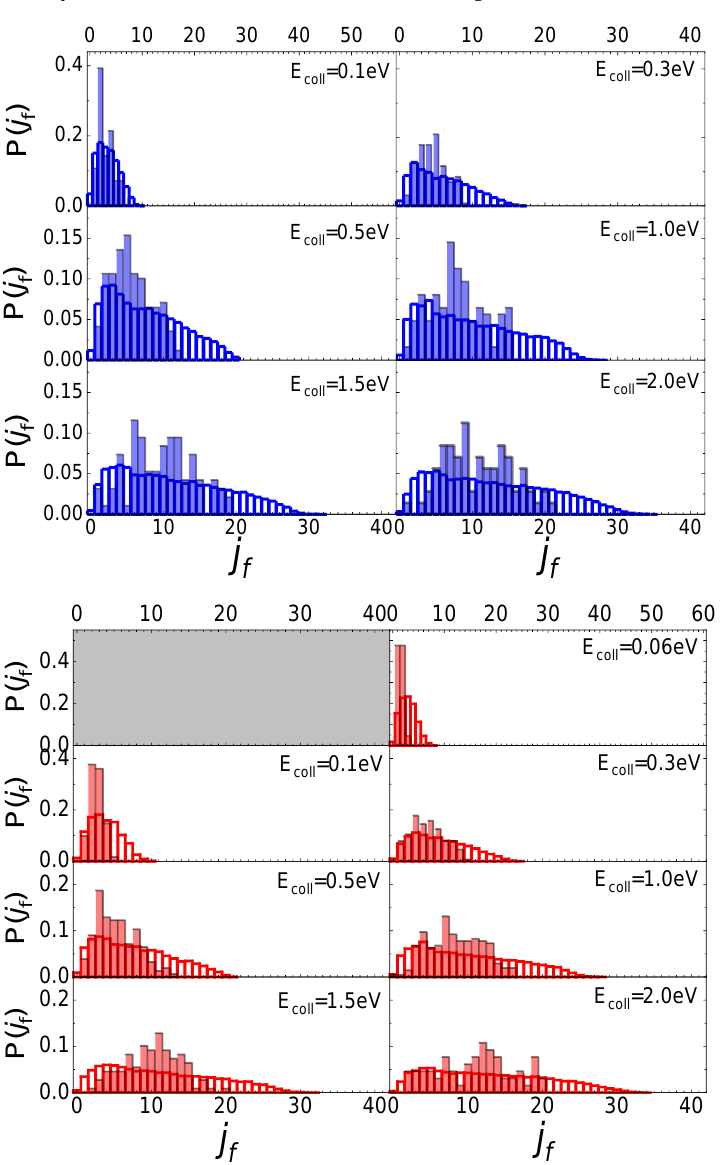
Figure 9. Final rotational distributions for ortho ( upper panel ) and para ( lower panel ) N 2 molecules inelastically scattered by quartz (in foreground) compared with those obtained in ref. [29] for cristobalite (in transparency) as a function of the collision E coll of impinging molecules.